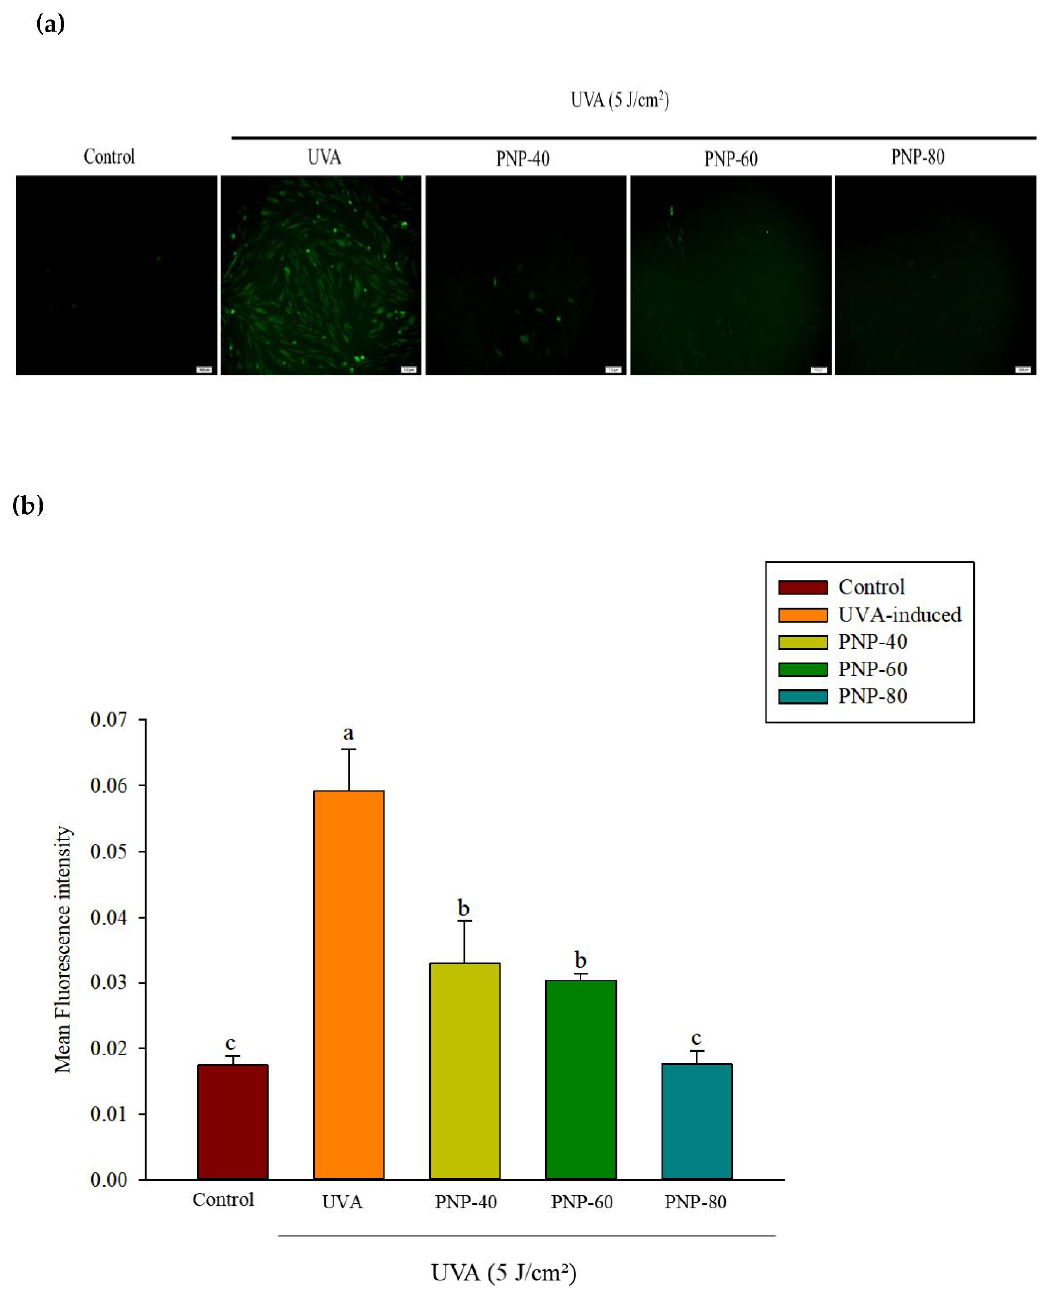
Figure 5. ( a ) Radical scavenging activity of PNPs (250 µ g/mL) on Hs68 cells against UVA-induced ROS generation (scale bar = 100 µ m, magnification: 10 × 10). ( b ) Quantitative analysis (performed using Image J software) of the radical scavenging effect of PNPs on Hs68 cells against UVA-induced ROS generation. Experiments were independently conducted in triplicate ( n = 3). Data are expressed as the mean ± SD. a – c: Matching lowercase symbols indicate significant differences between the different groups ( p < 0.05).